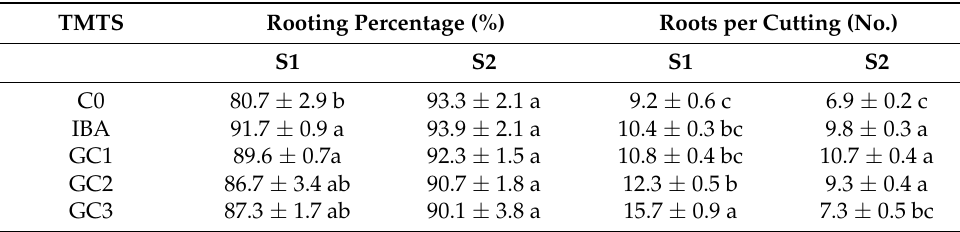
Table 1. Rooting percentage (%) and roots per cutting (no.) at 50 days after cutting in Lantana camara (S1) and Abelia × grandiflora (S2) influenced by rooting promoters at different concentrations (C). TMTS Rooting Percentage (%) Roots per Cutting (No.) S1 S2 S1